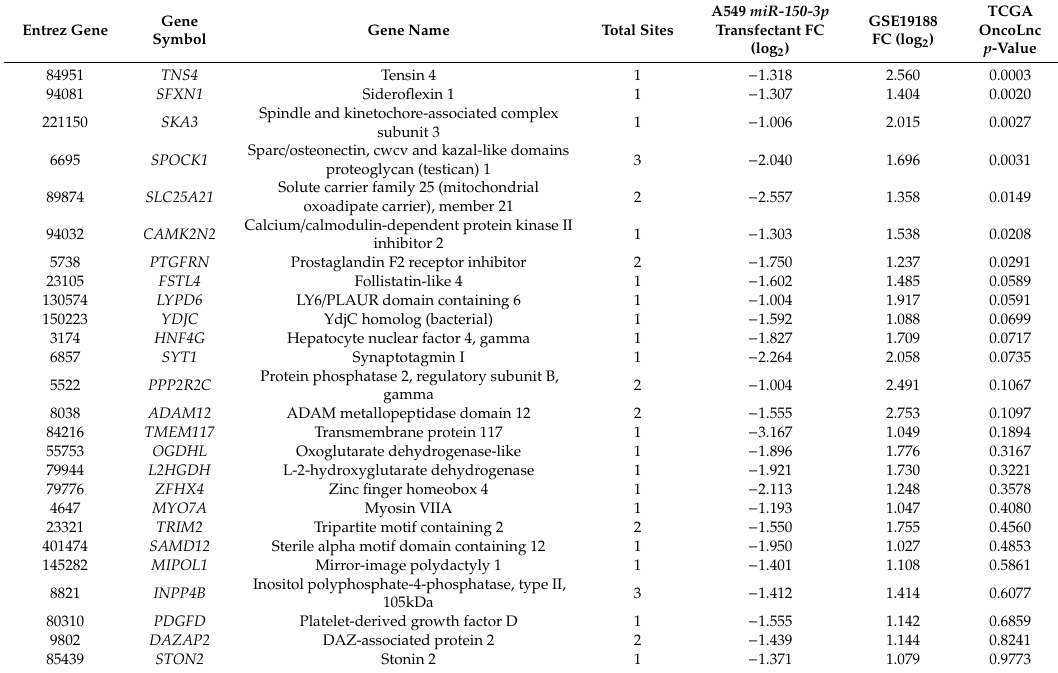
Table 3. Candidate target genes regulated by